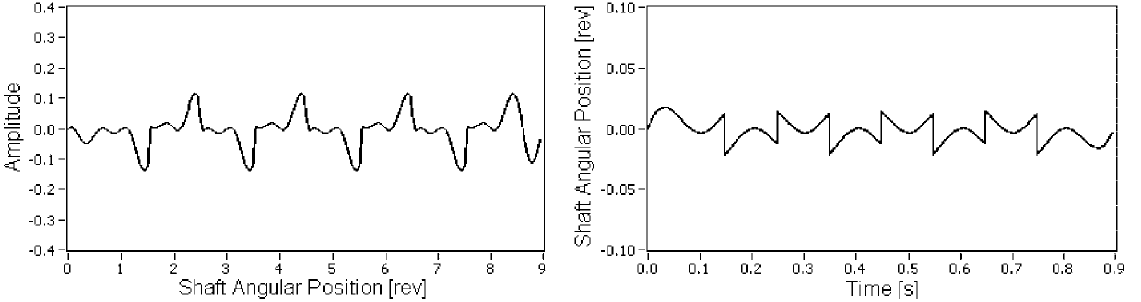
Fig. 11. Noise and difference between the resampled angle position, and the true angle position.